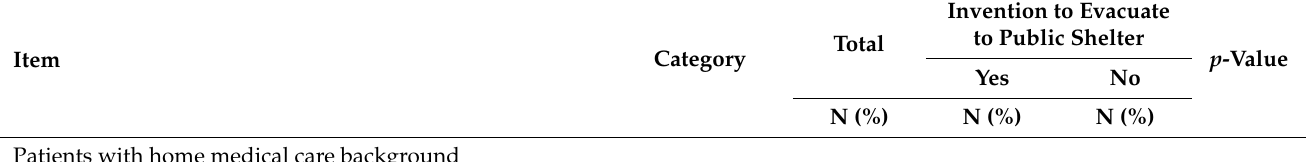
Table 1. Basic attributes, disaster preparedness, and intention to evacuate to a public shelter, by intention to evacuate (N =